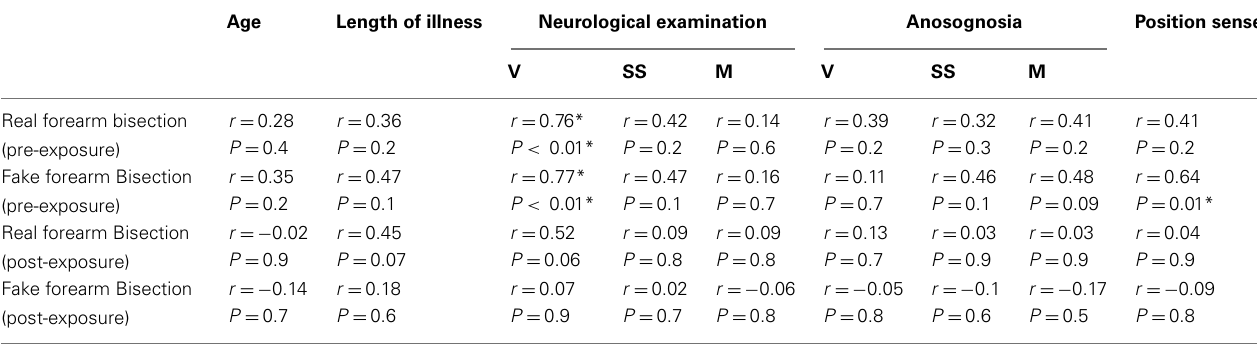
Table 3 | Correlation matrix between the bisection performances of RHD patients in the real and the fake forearm conditions, pre- and post-PA, and the demographic, neurological, anosognosia, and position sense (left forearm) scores.